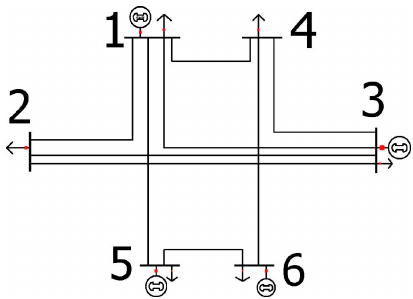
Figure 7. One-line diagram of the reduced IEEE 30-bus system.